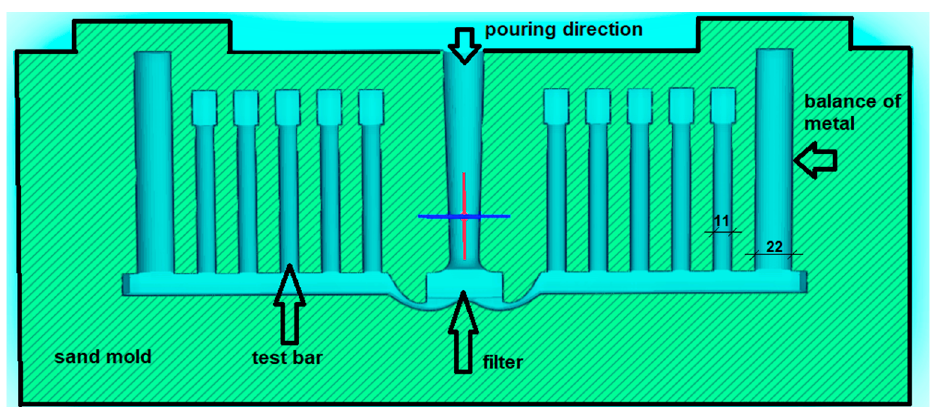
Figure 1. The draft of the sand mould used for casting of 10 test-bars for tensile strength tests. The two crucial diameters are given in mm, and the sketch scale is 1:1. Liquid metal is poured into the mould from the top opening; it passes the filter and feeds the 10 test-bars cavities (diameter 11 mm). The higher cavities on both ends (diameter 22 mm) balance the pressure to feed the mould correctly.